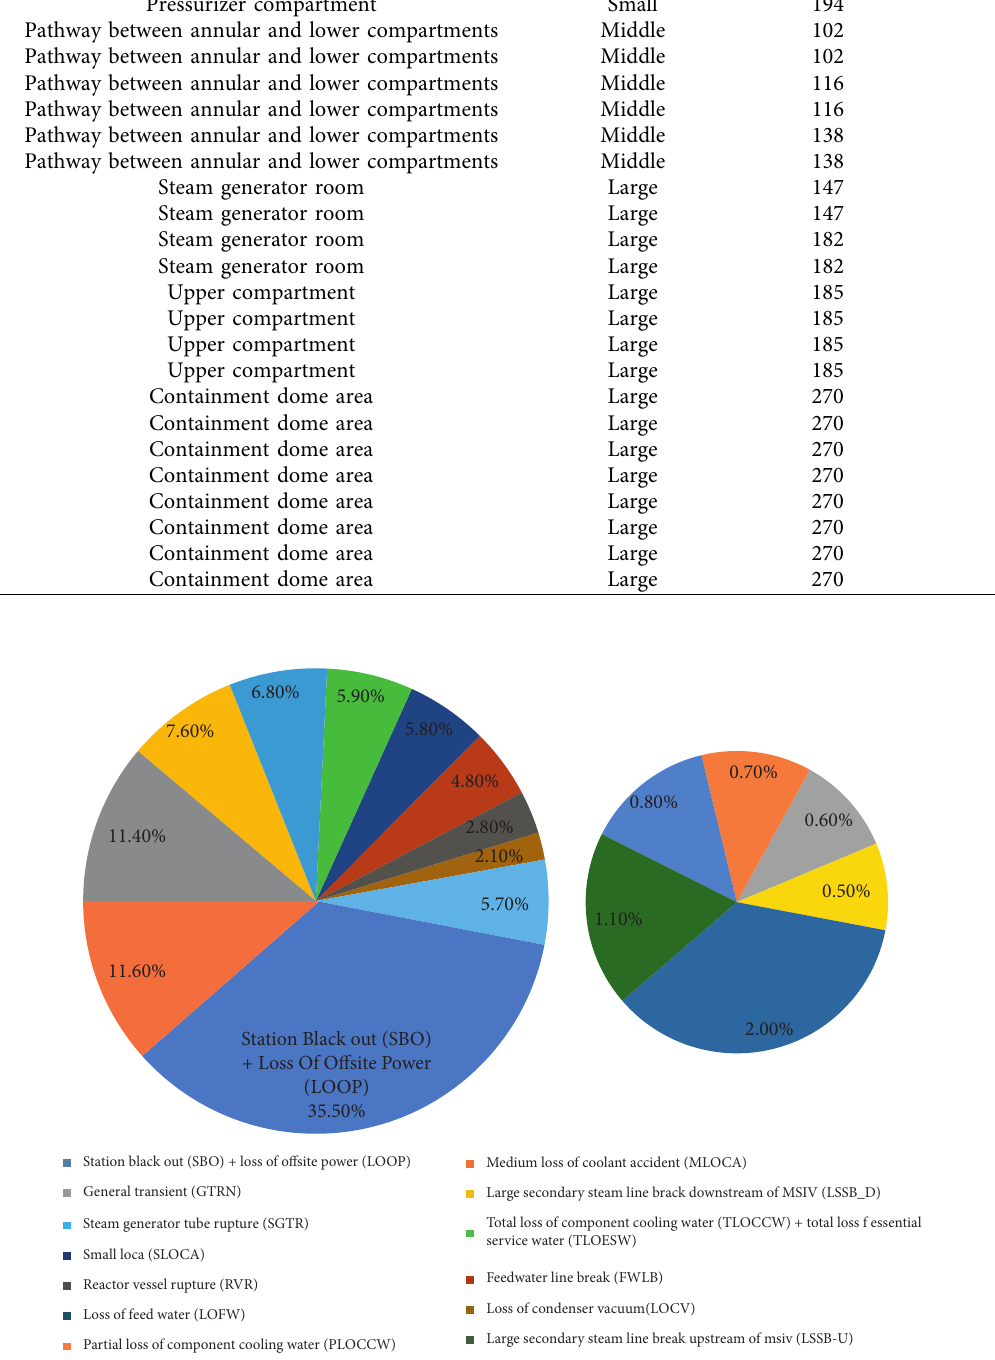
Figure 5: CDF contribution by initiating event.